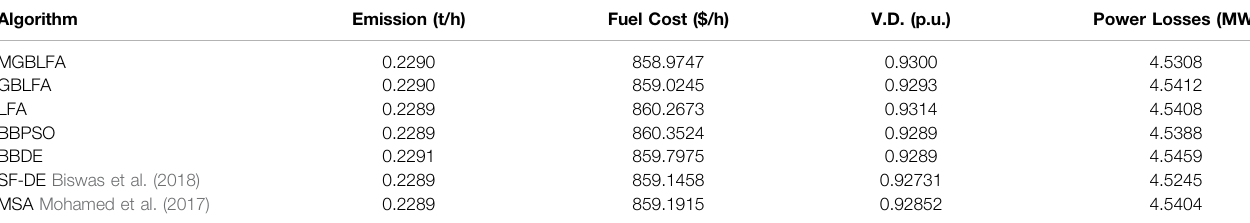
TABLE 7 | Comparison of optimal results by algorithms for Case 6. Algorithm